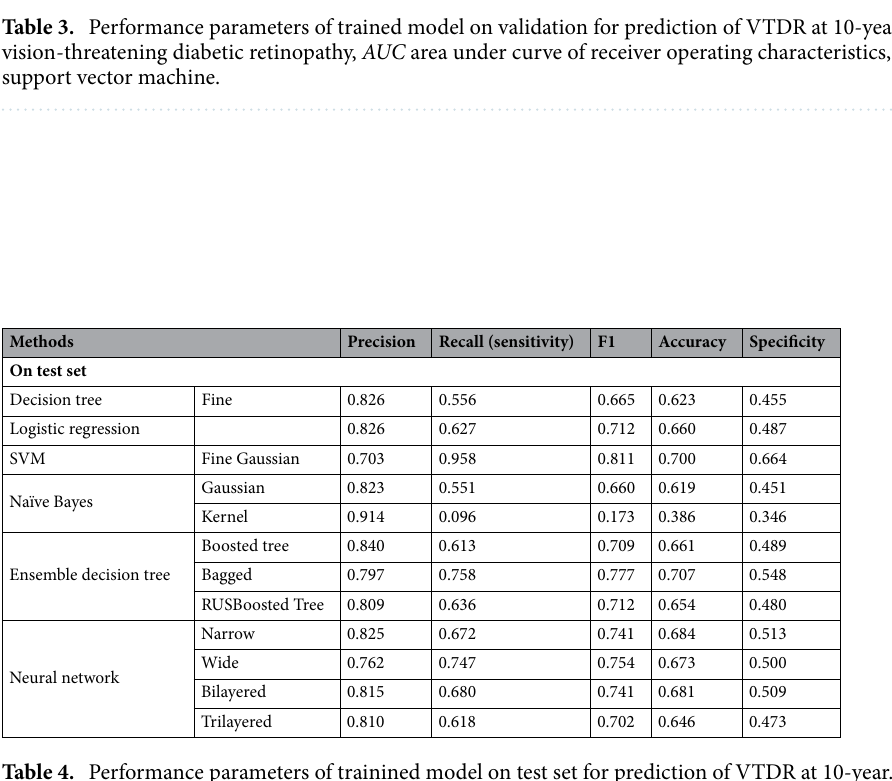
Table 4. Performance parameters of trainined model on test set for prediction of VTDR at 10-year. VTDR vision-threatening diabetic retinopathy, SVM support vector